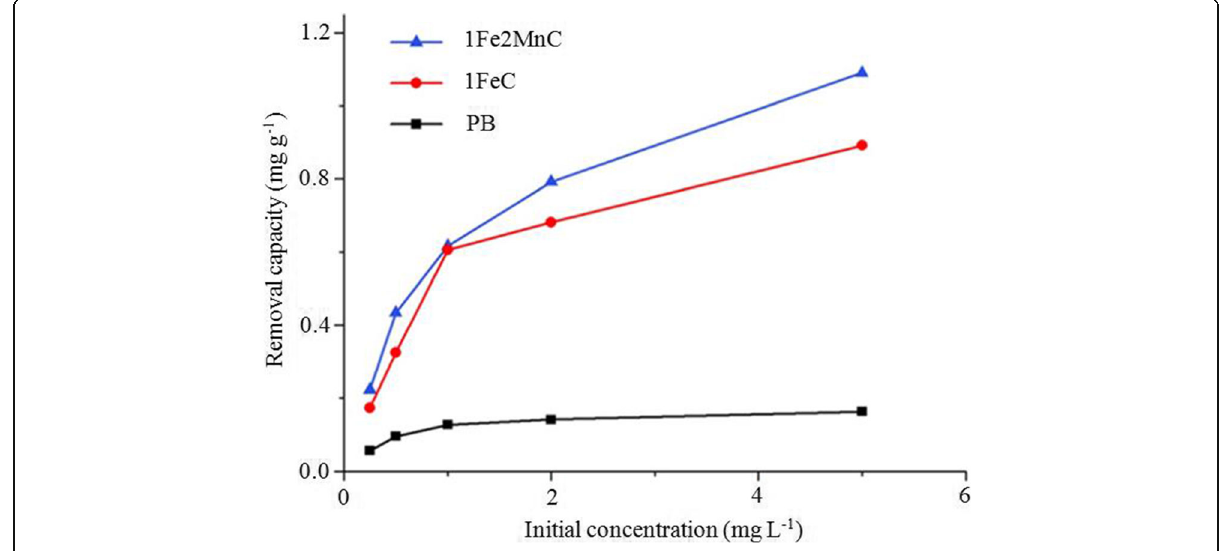
Fig. 8 The influence of initial concentration of As